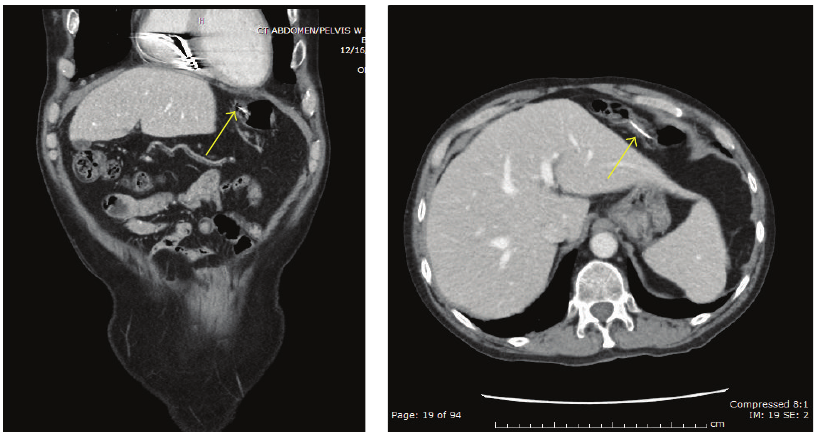
Figure 8: Coronal and axial images in soft tissue window revealing endoluminal extension of the migrating epicardial pacing wiring into the transverse colon (yellow